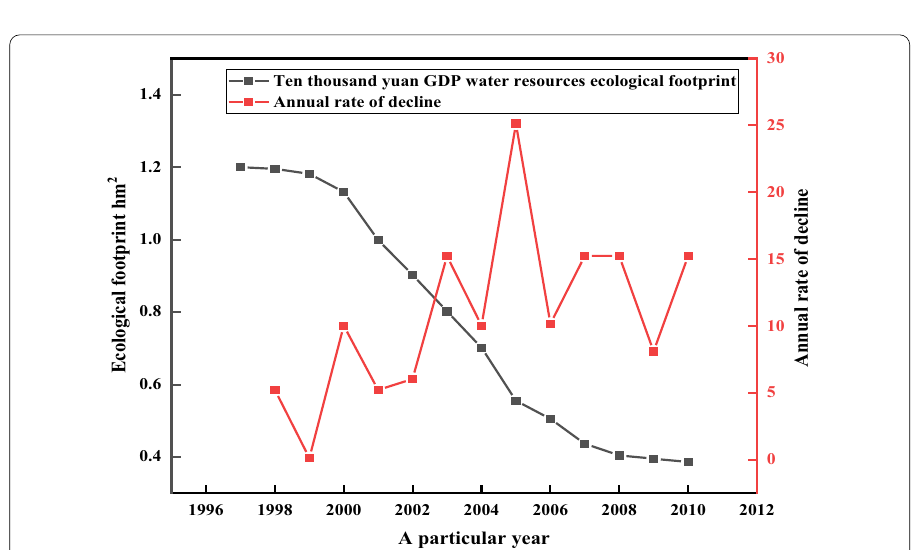
Fig. 5 Ecological footprint of GDP water resources in China from 1997 to